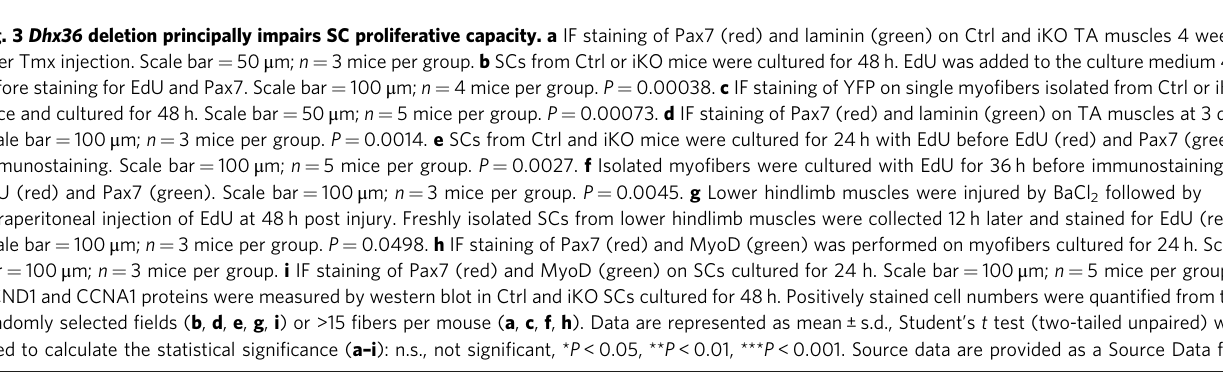
Fig. 3 Dhx36 deletion principally impairs SC proliferative capacity. a IF staining of Pax7 (red) and laminin (green) on Ctrl and iKO TA muscles 4 weeks after Tmx injection. Scale bar = 50 μ m; n = 3 mice per group. b SCs from Ctrl or iKO mice were cultured for 48 h. EdU was added to the culture medium 4 h before staining for EdU and Pax7. Scale bar = 100 μ m; n = 4 mice per group. P = 0.00038. c IF staining of YFP on single myo fi bers isolated from Ctrl or iKO mice and cultured for 48 h. Scale bar = 50 μ m; n = 5 mice per group. P = 0.00073. d IF staining of Pax7 (red) and laminin (green) on TA muscles at 3 dpi. Scale bar = 100 μ m; n = 3 mice per group. P = 0.0014. e SCs from Ctrl and iKO mice were cultured for 24 h with EdU before EdU (red) and Pax7 (green) immunostaining. Scale bar = 100 μ m; n = 5 mice per group. P = 0.0027. f Isolated myo fi bers were cultured with EdU for 36 h before immunostaining of EdU (red) and Pax7 (green). Scale bar = 100 μ m; n = 3 mice per group. P = 0.0045. g Lower hindlimb muscles were injured by BaCl 2 followed